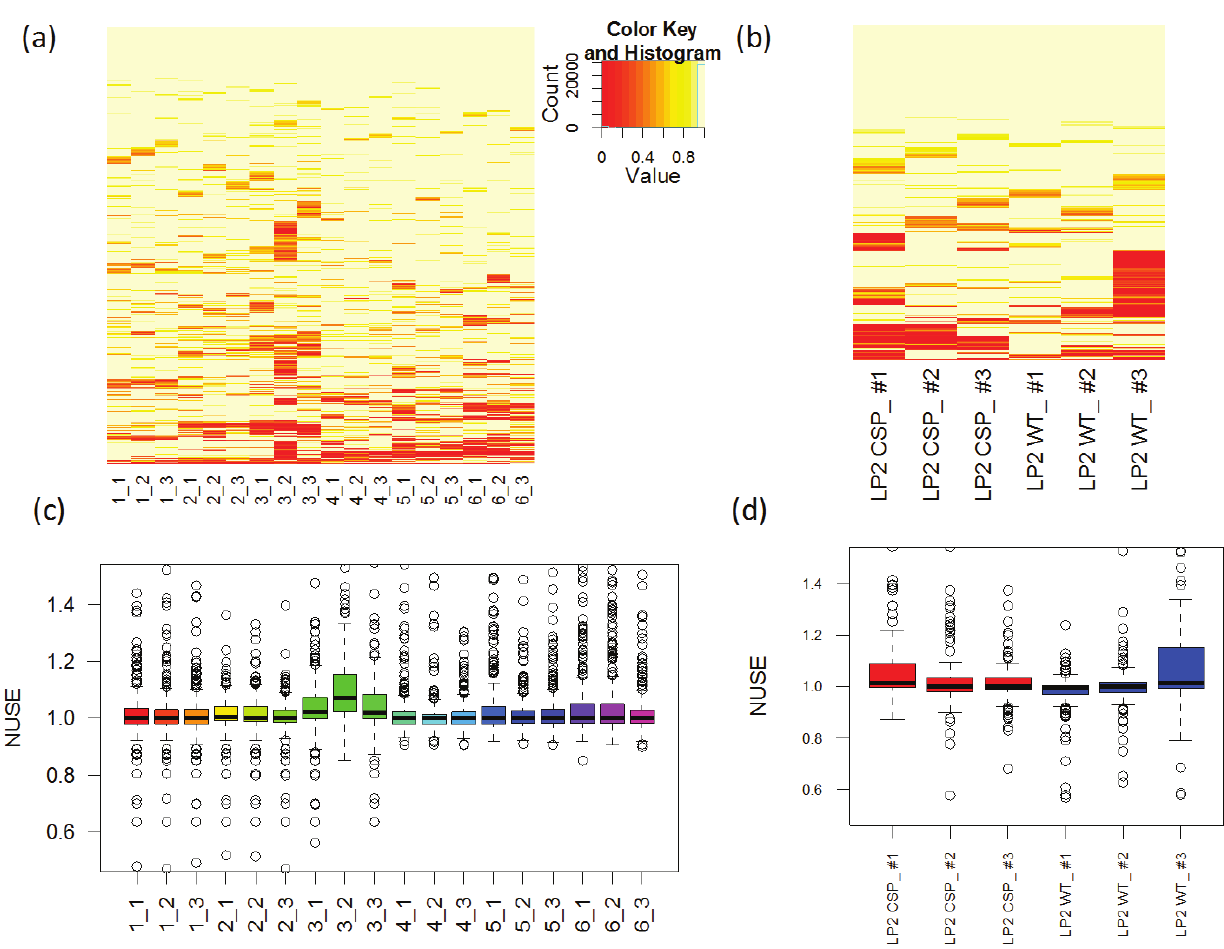
Figure 6. Individual weights are graphically summarized and Normalized unscaled standard error (NUSE) distributions are plotted for ( a ), ( c ) PSD and ( b ), ( d ) CSP data, respectively.